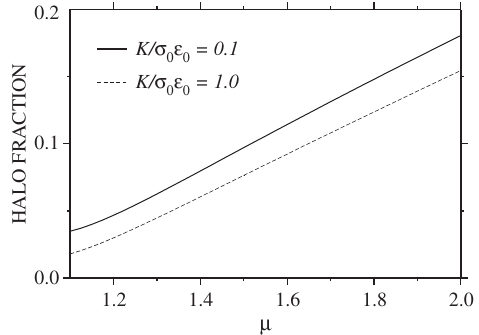
FIG. 4. Halo fraction F h as a function of the mismatch pa- rameter (cid:6) obtained from the theory, Eq. (27), for K=k (solid line) and K=k